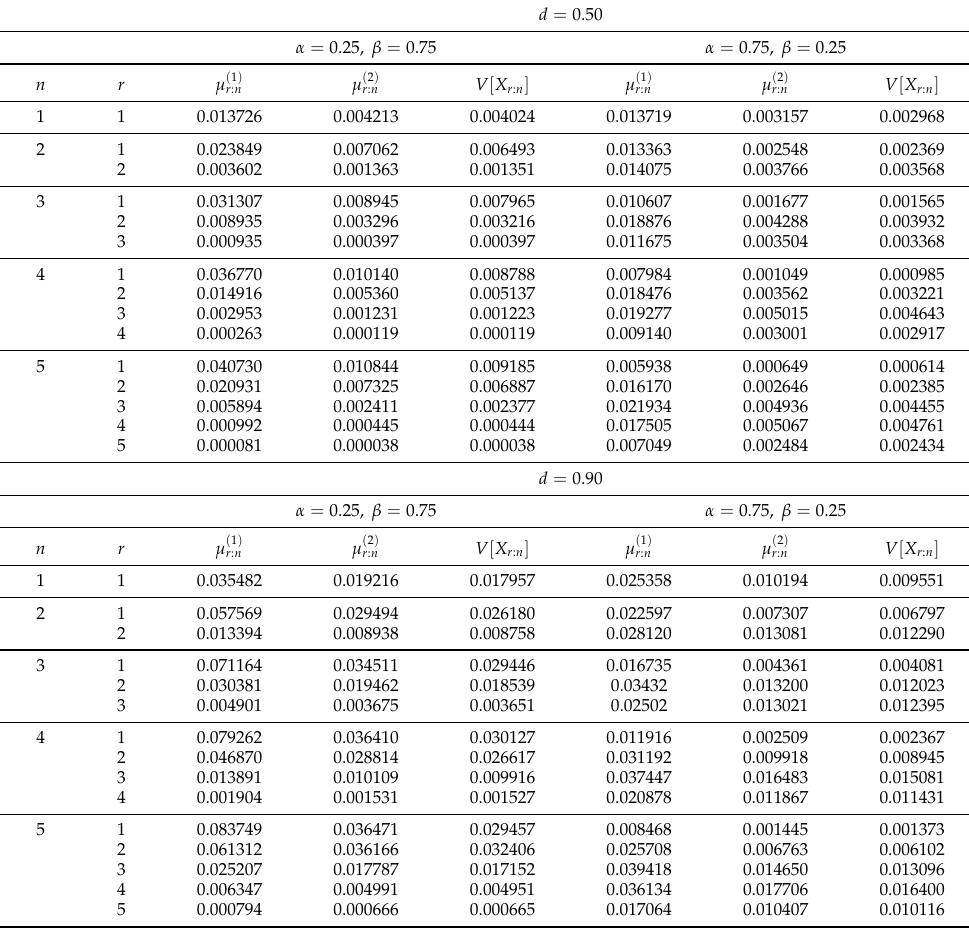
Table 1. Moments of order statistics from the omega distribution for several parametric